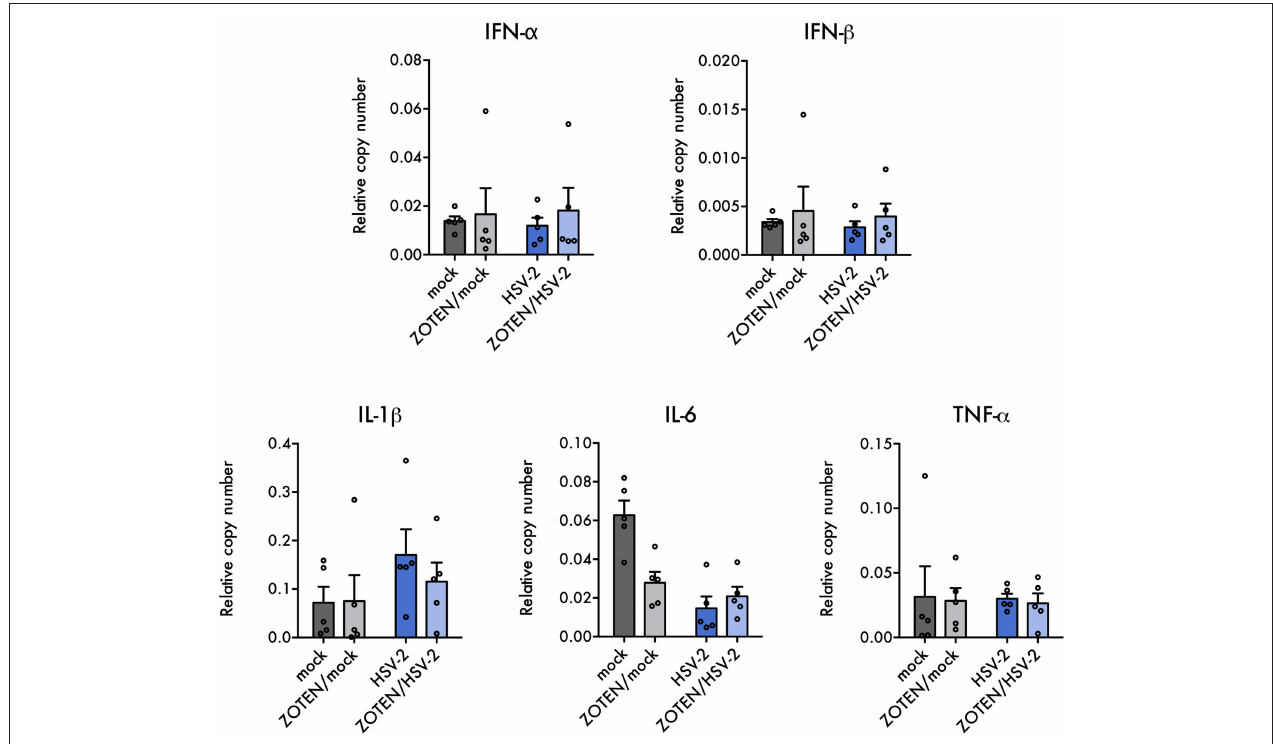
FIGURE 5 | Local cytokine expression in infection and ZOTEN treatment. Quantification of key antiviral type I interferon and pro-inflammatory cytokine transcripts in mice vaginal tissues. Copy numbers relative to b-actin are shown. Error bars indicate SEM ( n = 5 per